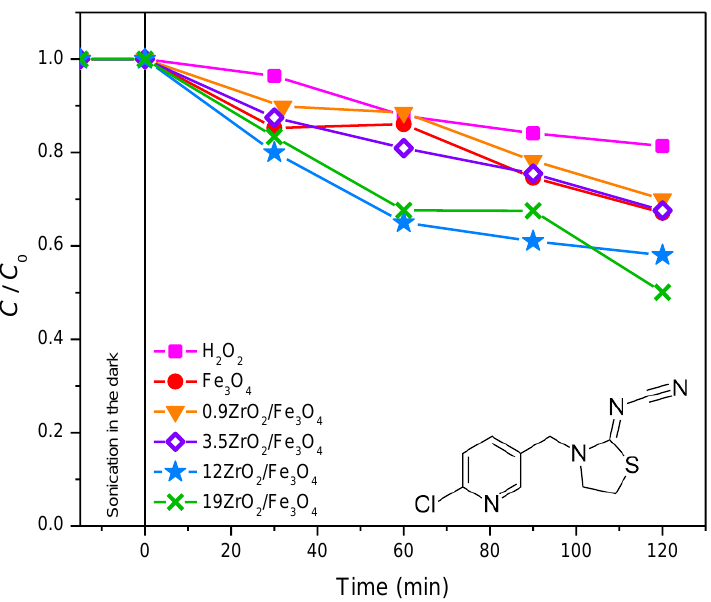
Figure 4. The influence of different photodegradation systems on the kinetics of thiacloprid (0.38 mmol/dm 3 ) photodegradation in the presence of 45 mmol/dm 3 H 2 O 2 and 0.42 mg/cm 3 catalyst at pH 2.8, using solar irradiation. Inset represents the structural formula of thiacloprid. By comparing the kinetic curves in Figure 4, it may be seen that using a heterogeneous 12ZrO 2 /Fe 3 O 4 /H 2 O 2 photo-Fenton system, the efficiency of thiacloprid